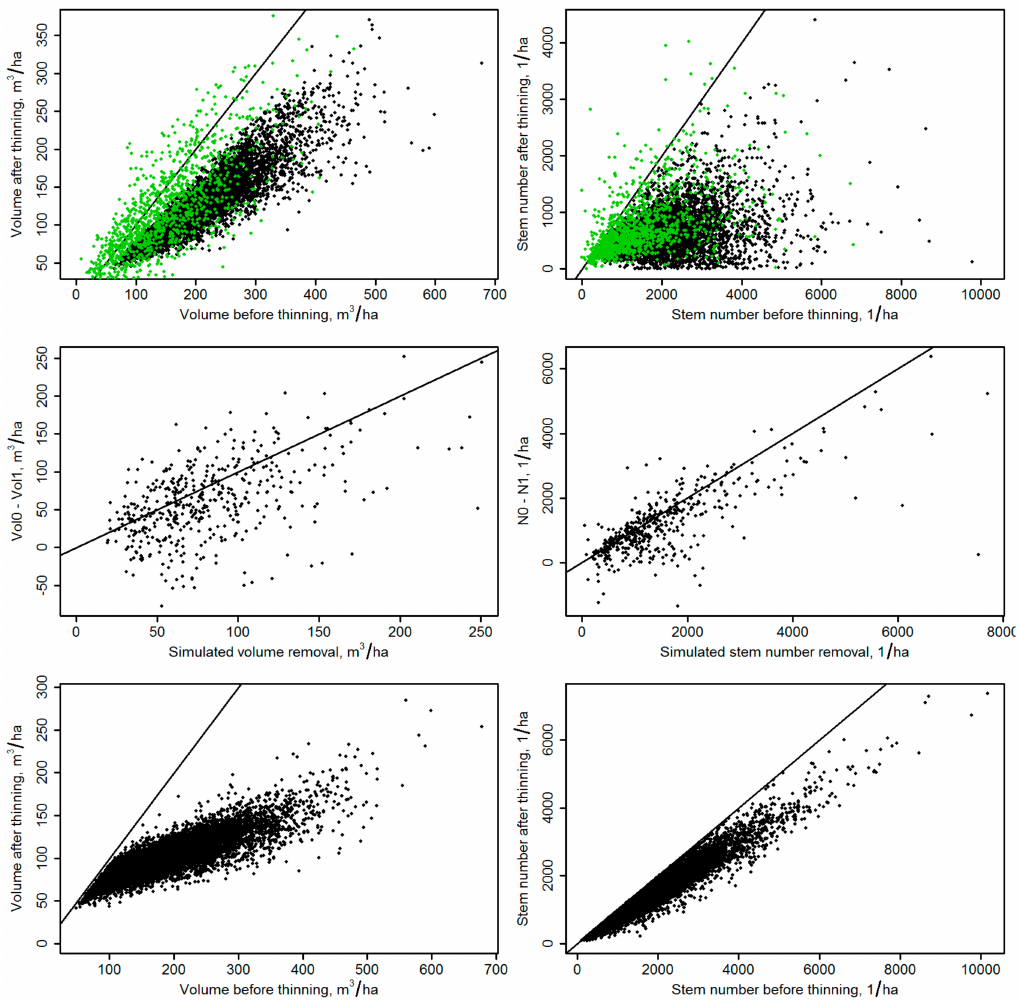
Figure 4. A comparison of the volume ( left ) and stem number ( right ) of the simulated harvests. Top row : Values before and after thinning from below , black and green dots corresponding to simulated values and pairwise observations of the permanent plots, respectively. Middle row : The correspondence of the simulated removal with the difference computed from the pairwise observations. Bottom row : Values before and after simulated thinning from